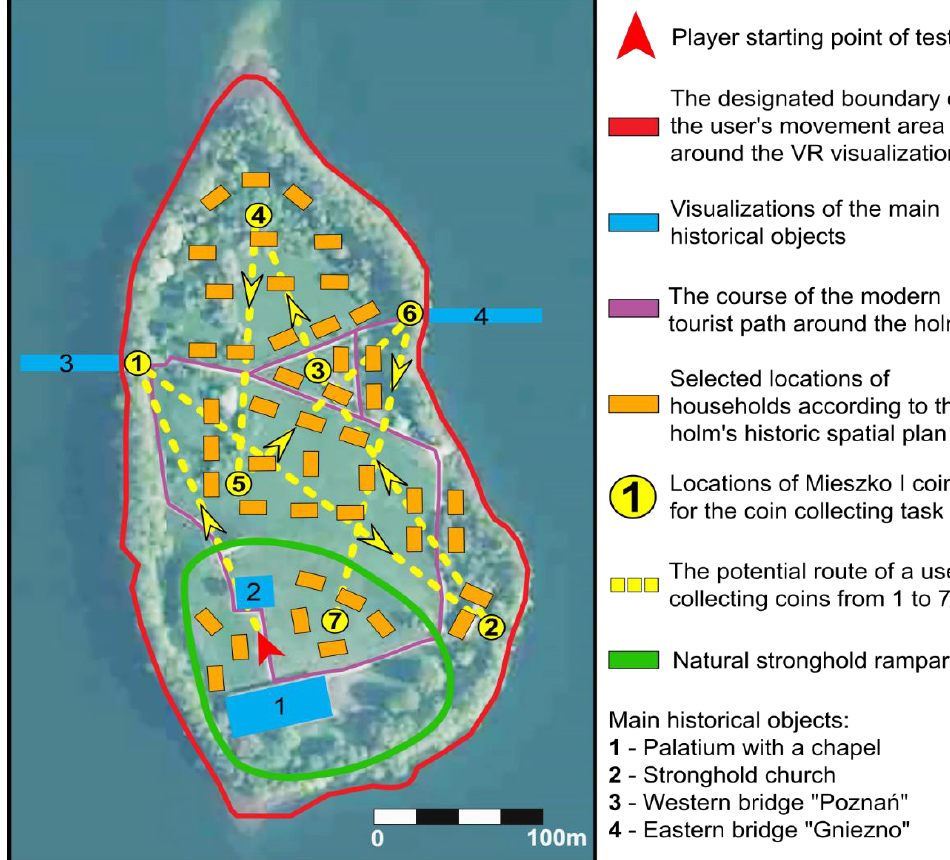
Figure 4. Equipment and room installation progress with HTC goggles (based on https: Figure 2. Equipment and room installation progress with HTC goggles (based on https:www.vive. www.vive.com) . com, accessed on 20 February 2021).